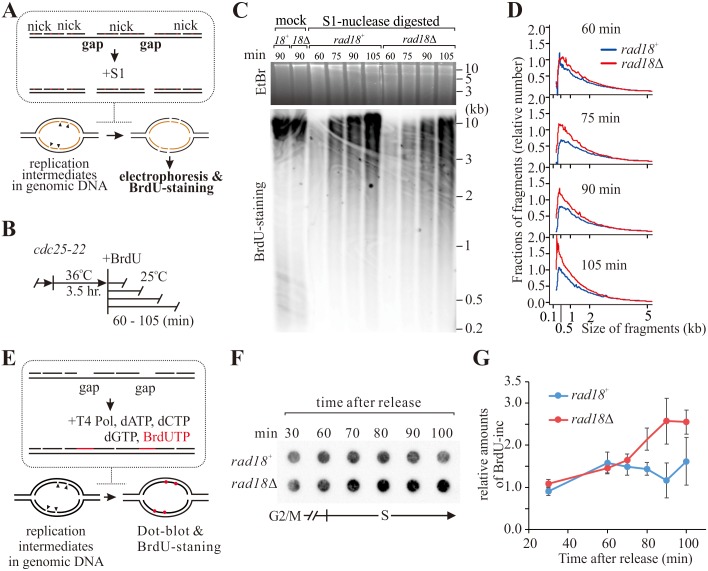
PCNA ubiquitylation mediates repair of ssDNA gaps during S-phase.(A) Schematic of the S1 nuclease assay [36] used to monitor gaps during DNA replication. (B) Experimental scheme. cdc25-22 cells were synchronised at G2 phase by temperature shift then released into the cell cycle and samples harvested at the indicated time points. (C) Analysis of S1-nuclease digested total DNA. Samples were subjected to agarose gel electrophoresis and visualised by ethidium bromide (EtBr) staining to reveal the total DNA (top) and subjected to BrdU antibody detection to reveal newly synthesised strands (bottom). (D) Quantification of S1-nuclese digested fragments. Fractions of fragments along the axis of fragment length were calculated from the intensity of BrdU signals in C. (See S7 Fig for the calculation steps). (E) Schematic of the BrdU assay used to monitor gaps during DNA replication. (F) detection of BrdU incorporated into the indicated DNA samples prepared in agarose plugs. Experimental scheme as in B. (G) Quantification of BrdU incorporation. Plotted data are derived from three independent experiments.